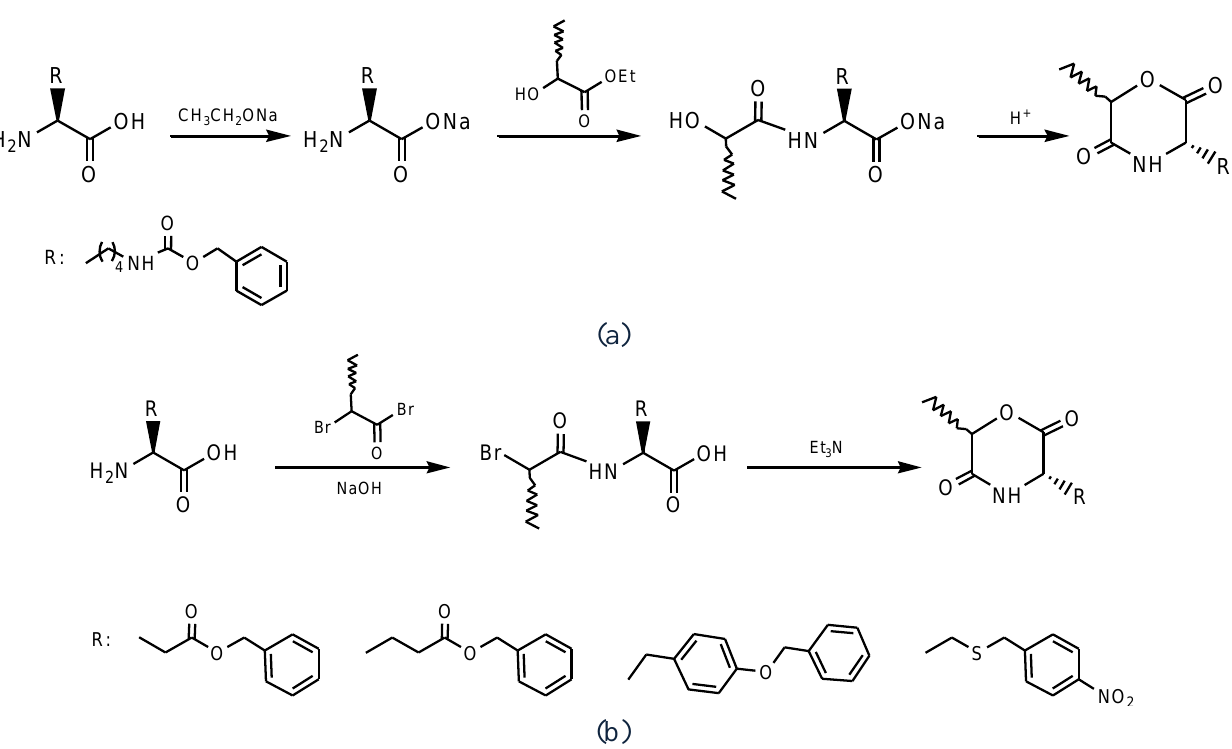
Figure 8. Synthesis of morpholine-2,5-diones constituted by  -amino acids with protected amine ( a ) and carboxyl, hydroxyl or thiol ( b ) functional